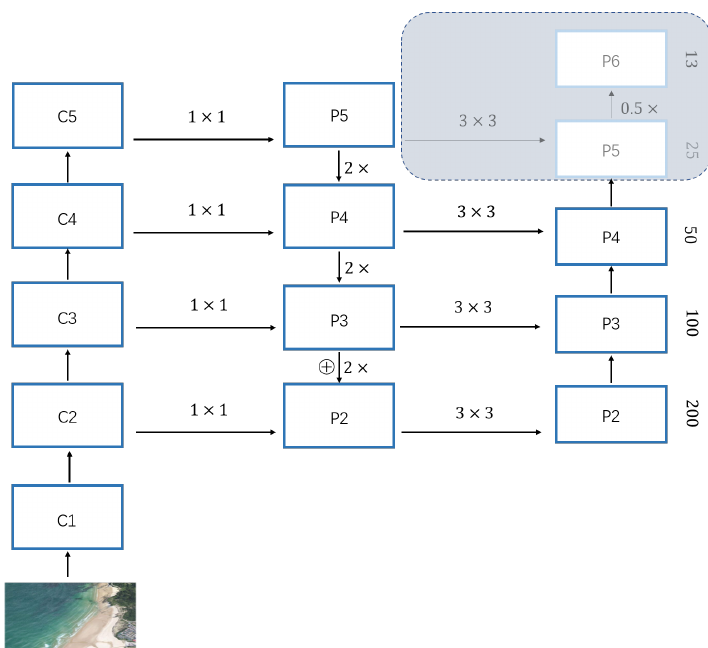
Figure 3. The framework of FPN. C1-C5 indicate ResNet convolution layers; 1 × 1 and 3 × 3 denote 1-dimensional convolution and 3-dimensional convolution operations, respectively; 2× denotes 2-fold upsampling, and 0.5× denotes 0.5-fold downsampling, i.e., max-pooling; ⊕ stands for the element- wise summing operation; P2–P6 denote the output fused feature maps; 200, 100, 50, 25, and 13 are the corresponding dimensions of feature maps of